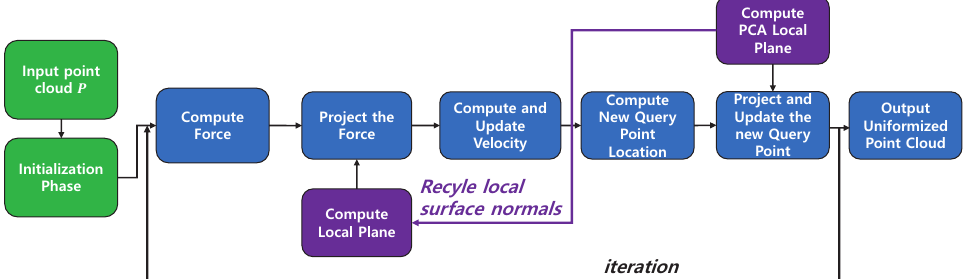
Figure 1. Overview of point cloud resampling algorithm. The input point cloud P is assumed to be zero-centered and rescaled. First, the resampled point cloud Q 0 , velocity V 0 , and the normal vectors N P of the local tangent plane are initialized. In each iteration, we perform the following procedures: Q 0 We compute the K -nearest neighbors from Q t − 1 to calculate the net electric force. Then, the normal vectors of the local tangent planes, calculated in the previous iteration, are used to project the forces to the local surfaces. The next velocities and the new query point cloud Q t are computed based on the forces additionally modified with damping terms. Then, we obtain the K -nearest neighbor for the updated point cloud Q t and calculate the local tangent planes. To prevent Q t from diverging, we project it using these new tangent planes. These planes can be reused in the next iteration to project electric forces for efficiency. After the iteration converges, the final output point cloud is rescaled to the original scale and is relocated to have the original center point.